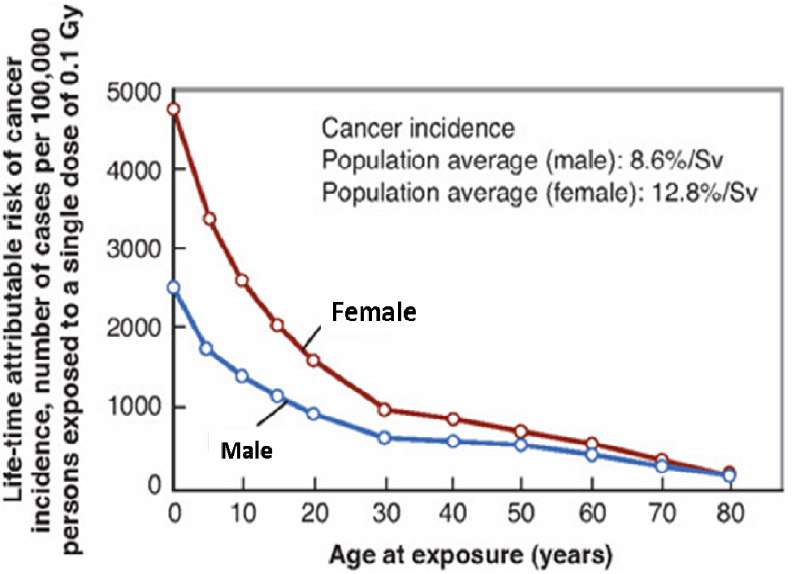
Figure 2. Cancer incidence as a function of age for males and females based on A-bomb data as calculated by BEIR VII committee (reproduced with permission from reference [14]).